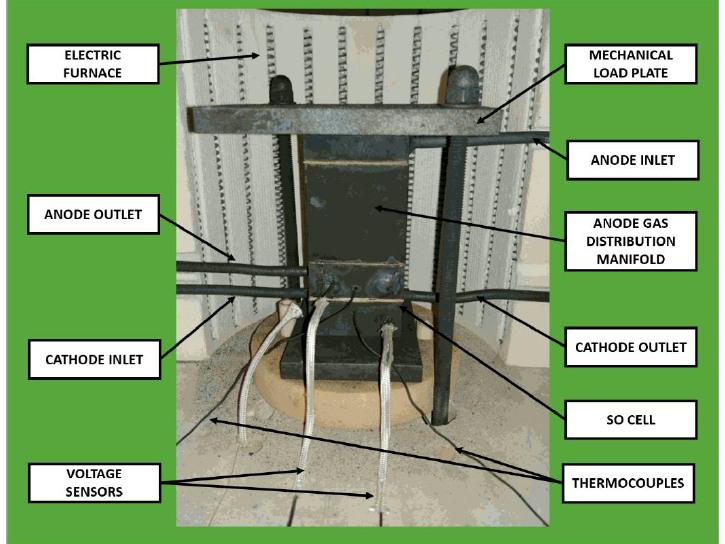
Figure 2. rSOC test apparatus: cell housing.